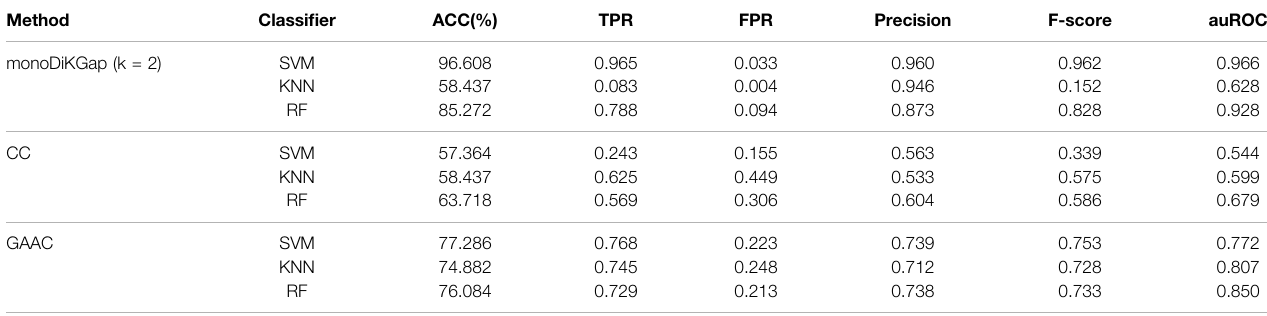
TABLE 1 | Compare the results of different feature methods under different classi fi ers. Method